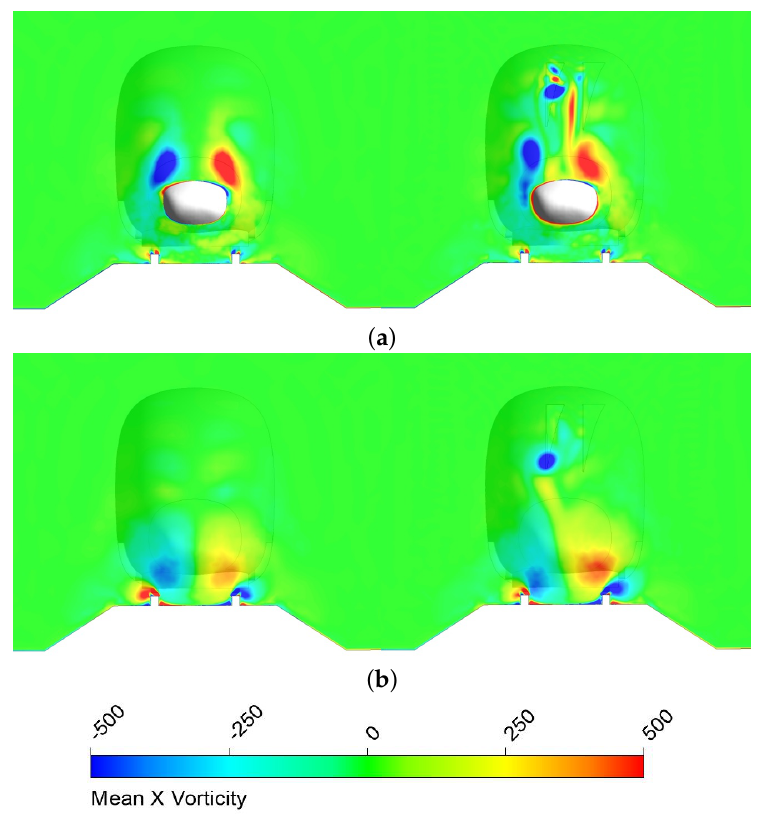
Figure 5. Mean x –vorticity comparison of (left) baseline and (right) parallel fins at planes located ( a ) 0.1 L Ref upstream of tail and ( b ) 1 L Ref downstream of tail. Fins were angled to deflect the wake to the left